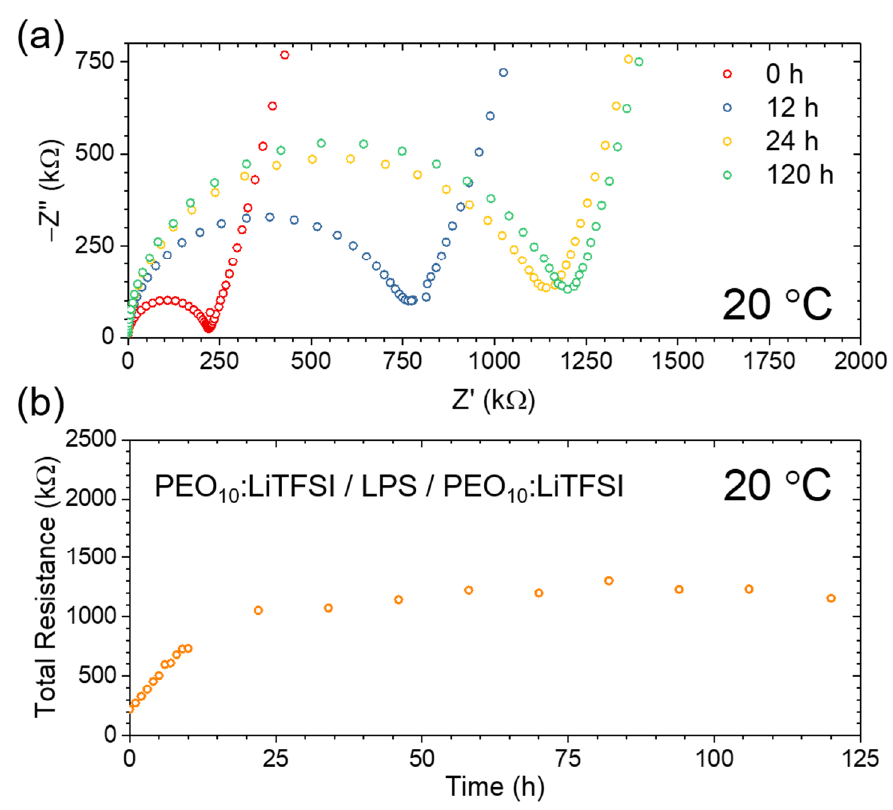
Figure 5. PEIS as a function of time for the PEO 10 :LiTFSI/LPS/ PEO 10 :LiTFSI trilayer. Here, ( a ) shows Nyquist plots after 0 h (red), 12 h (blue), 24 h (yellow) and 120 h (green); ( b ) shows the total resistance of the trilayer as a function of time.